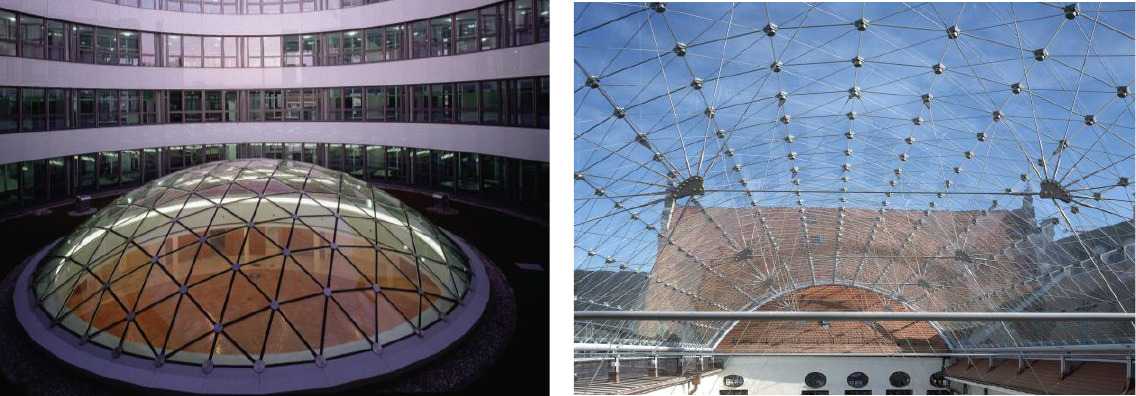
Fig. 7 Glass dome of the Weltbild Verlag, Augsburg (© seele). Fig. 8 Barrel-vault roof of the Maximilianmuseum, Augsburg